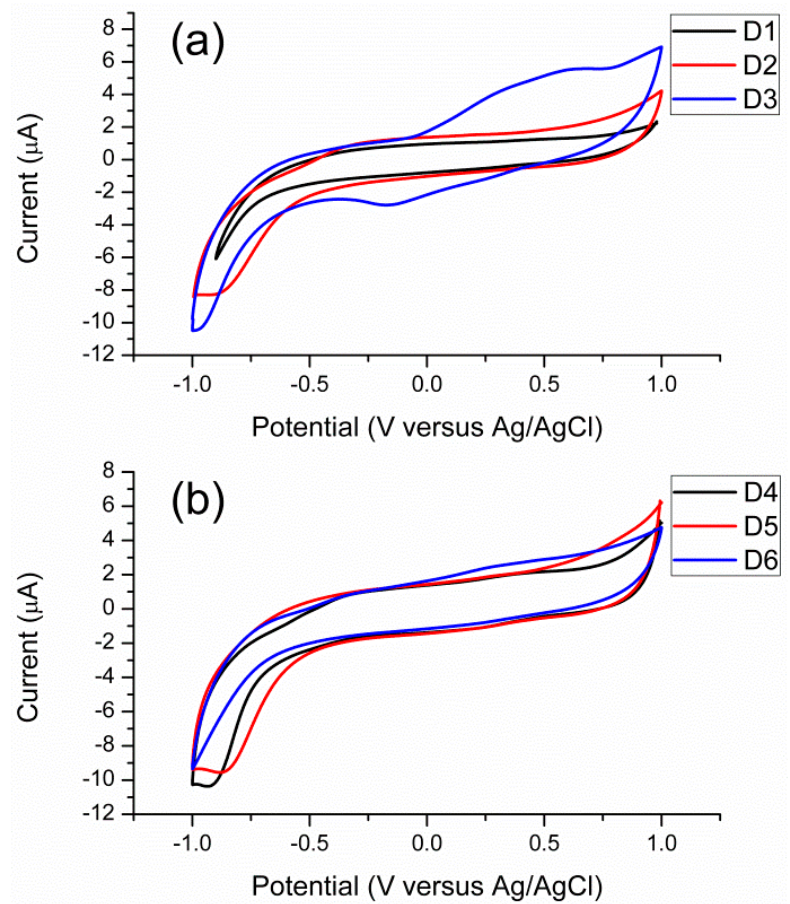
Figure 6. Cyclic voltammograms of the six natural dyes. ( a ) dyes D1-D3; ( b ) dyes D4-D6;